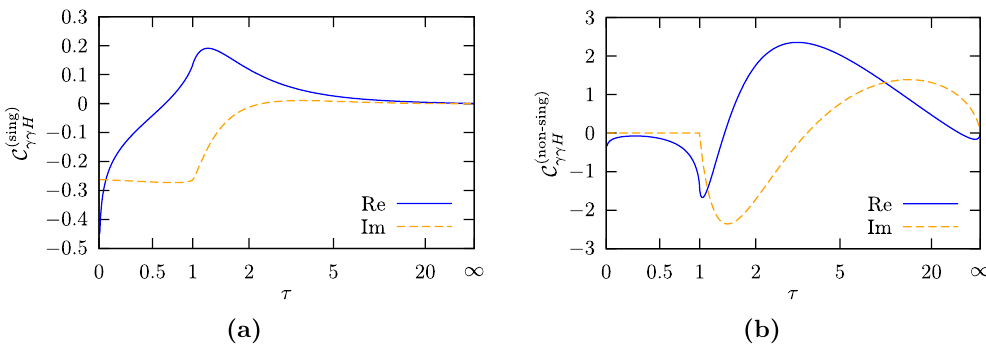
Figure 2 . Singlet and non-singlet part of C (2) with the quark mass renormalized in the on-shell (cid:13)(cid:13)H scheme and (cid:22) 2 = M 2 H